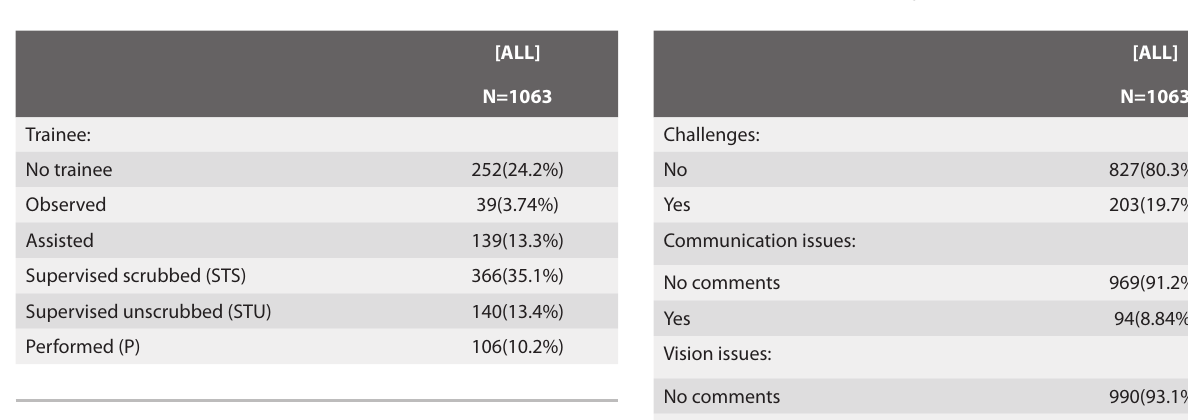
Table 6. Trainee involvement. Table 7. Intra-operative